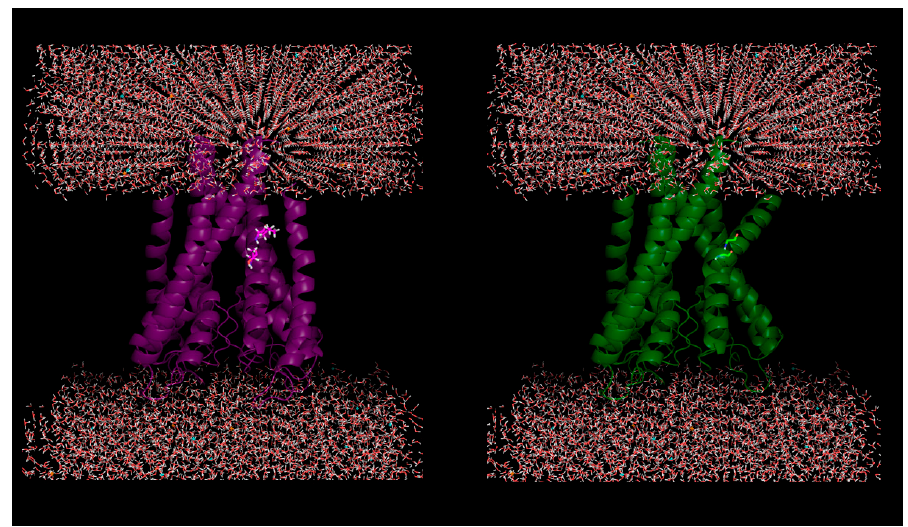
Figure 1. Plausible effect of mutations in membrane proteins: Helical kink is introduced due to in silico mutations of two successive residues (100-Ile, 101-Thr) to glycine (helix breaker) in a KcsA potassium channel protein (PDB ID: 1J95).